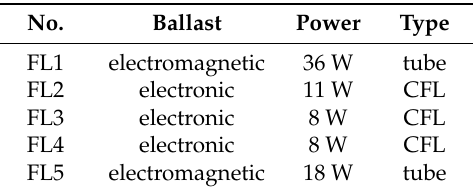
Table 3. List of tested fluorescent